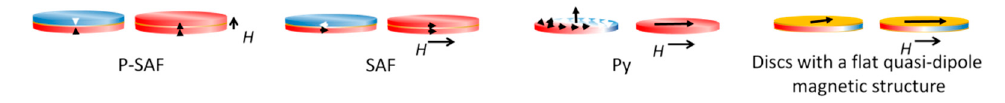
Figure 2. Magnetic discs are used to destroy tumor cells: synthetic antiferromagnetic P-SAF and SAF, vortex Py, and three-layer non-magnetic–ferromagnetic–non-magnetic systems with a flat quasi-dipole magnetic structure. P-SAF: Out-of-plane magnetic moments. Zero remanences. Under a magnetic field, the disc is magnetized with out-of-plane net magnetization. SAF: In-plane magnetic moments. Zero remanences. Under a magnetic field, the disc is magnetized with in-plane net magnetization. Vortex Py: In-plane magnetic moments. Zero remanences. Under a magnetic field, the disc is magnetized with in-plane net magnetization. Discs with a flat quasi-dipole magnetic structure: In-plane magnetic moments. Zero remanences. Under a magnetic field, the disc is magnetized with in-plane net magnetization.